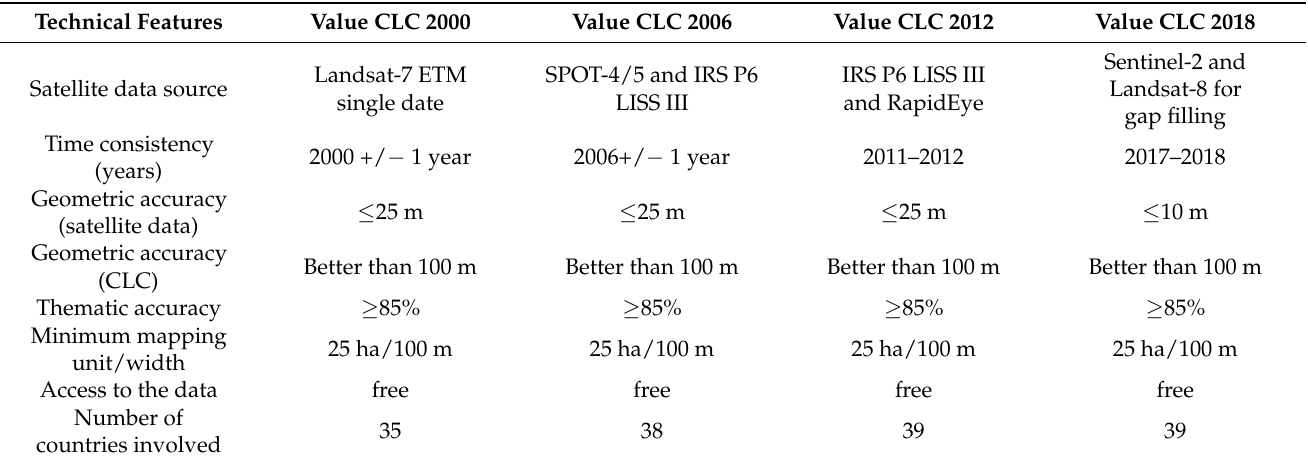
Table 2. Technical features of the Corine Land Cover (CLC) data (2000, 2006, 2012, and